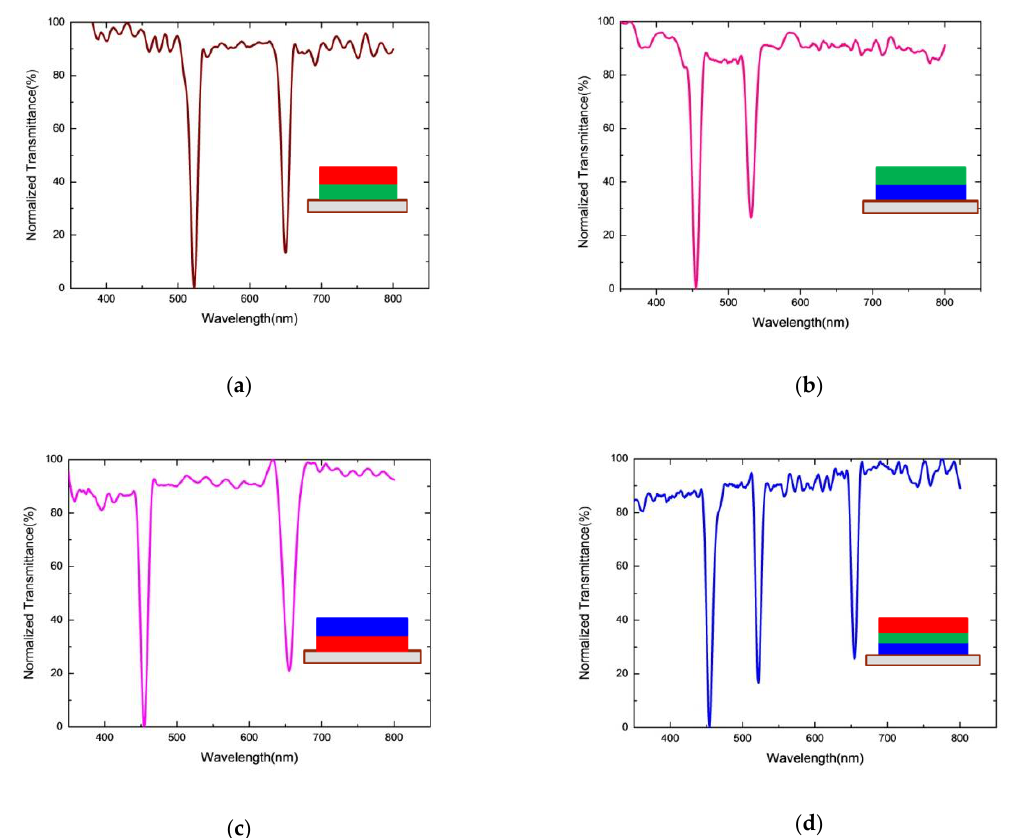
Figure 8. The normalized reflection spectrum of ( a ) the red / green filter, ( b ) the blue / green filter, ( c ) the blue / red filter, ( d ) the red / green / blue filter with a multi-layer template blue phase liquid crystal measured under polarized